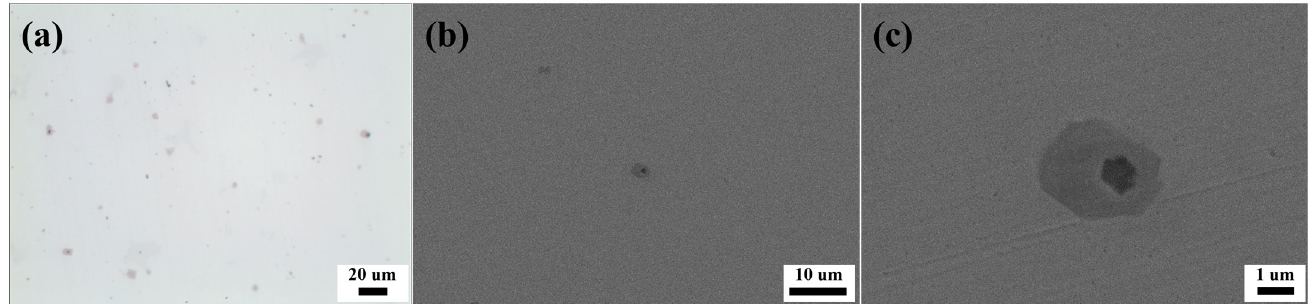
Figure 8. Microstructural evolution during homogenization treatment. ( a ) OM image 500×, ( b ) SEM image 5KX, and ( c ) SEM image 32KX.